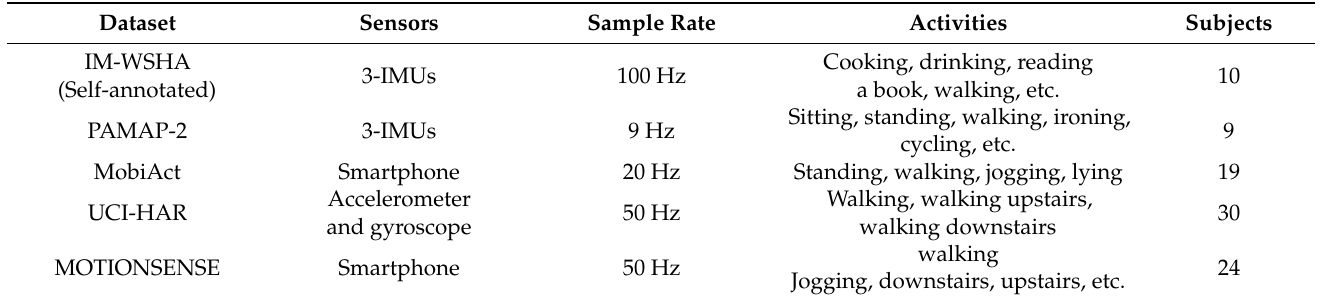
Table 1. A detailed comparison of our self-annotated IM-WSHA dataset and other benchmark datasets with sample sizes, other similarities, and differences.